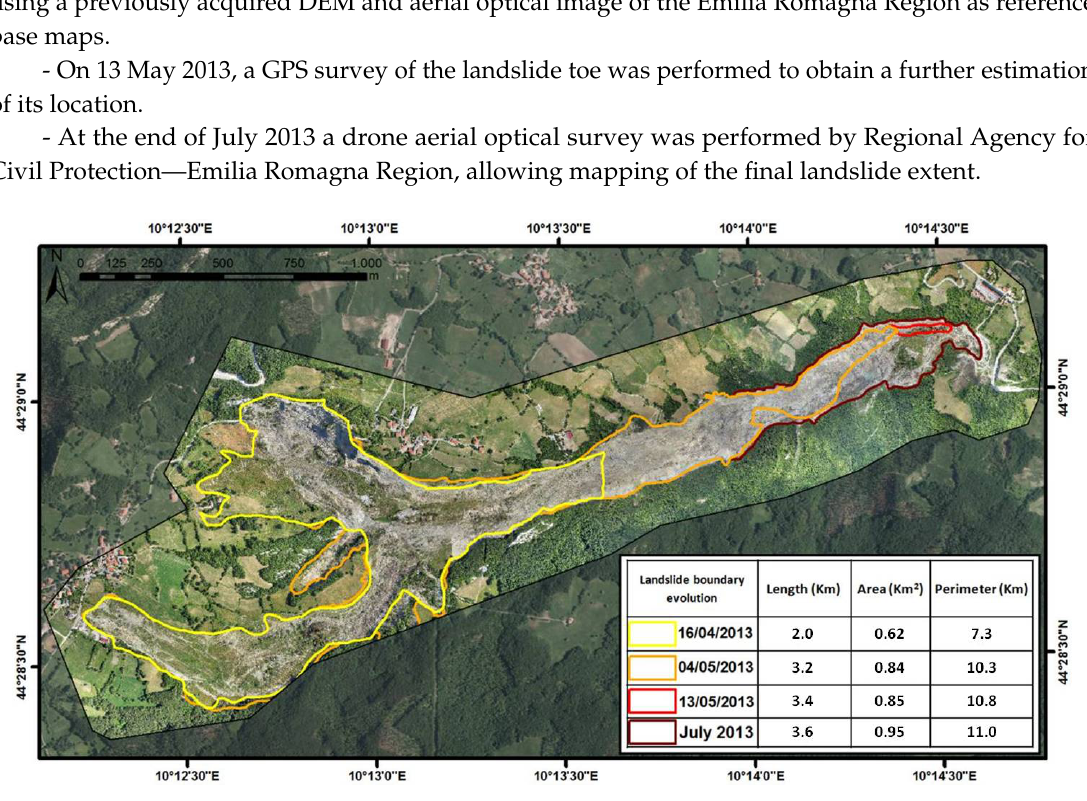
Figure 5. Map of the landslide evolution from 16 April to July 2013. The table summarizes the landslide morphometric parameters’